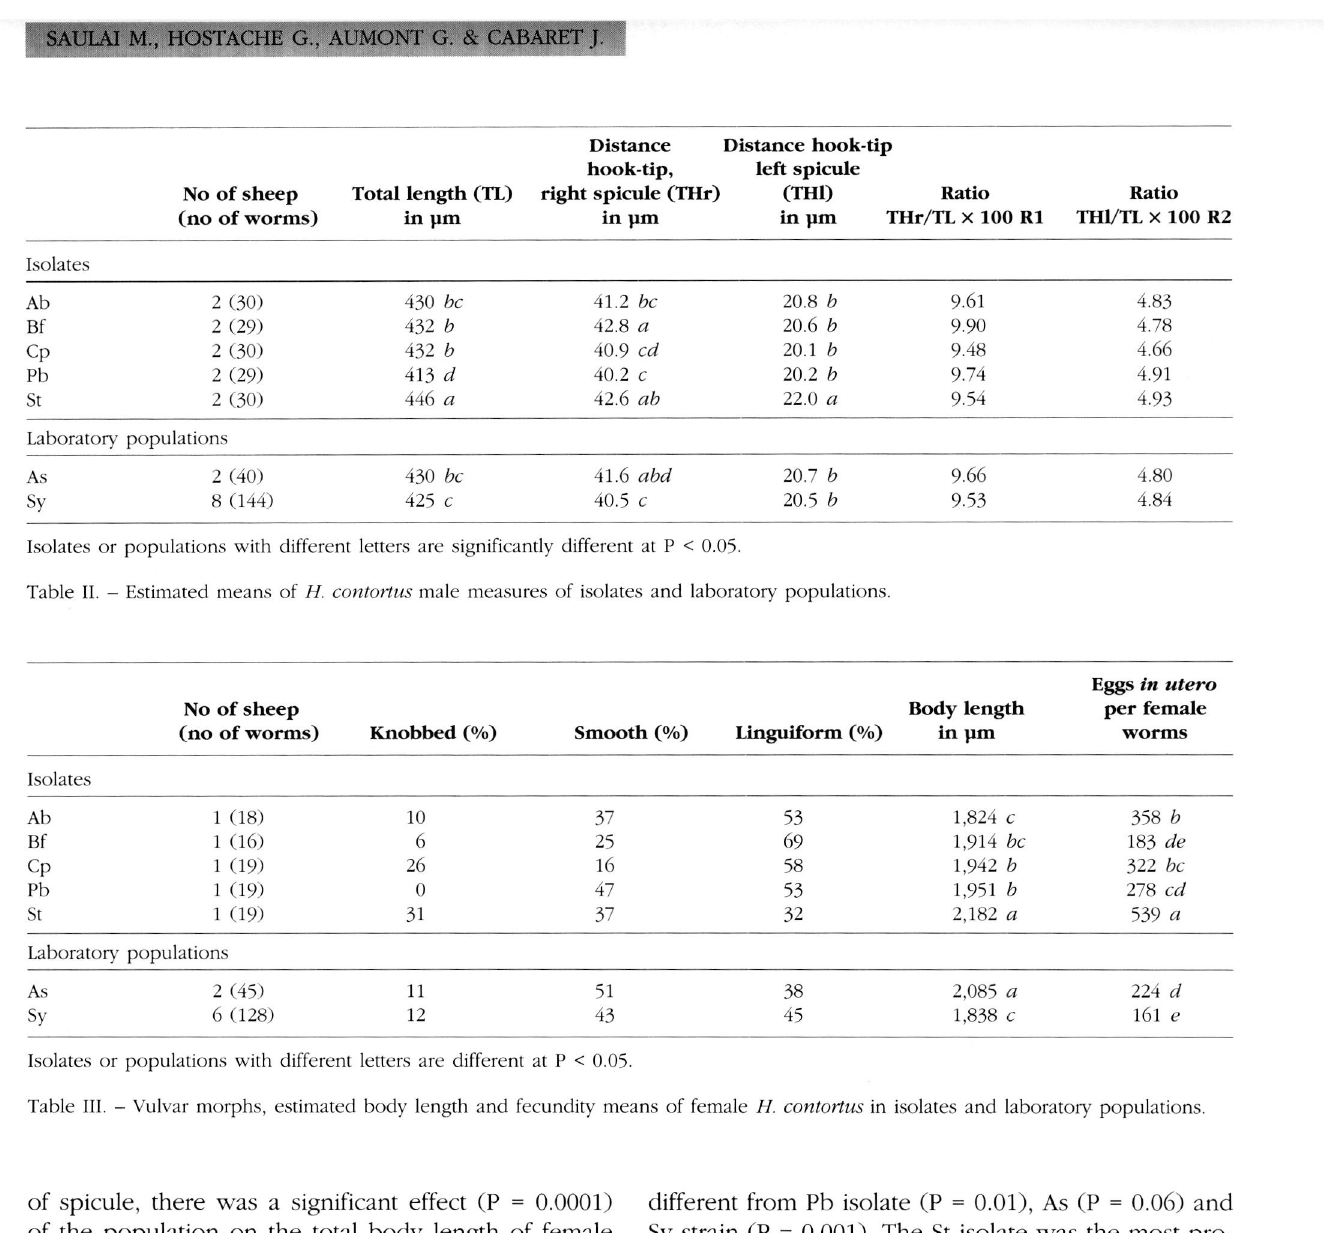
of spicule, there was a significant effect (P = 0.0001) of the population on the total body length of female worms. The St isolate was different from all the isolates and Sy strain for the total length (P = 0.0001). The As population was significantly different from Ab and Bf isolates and from Sy strain (P = 0.0001) (Table